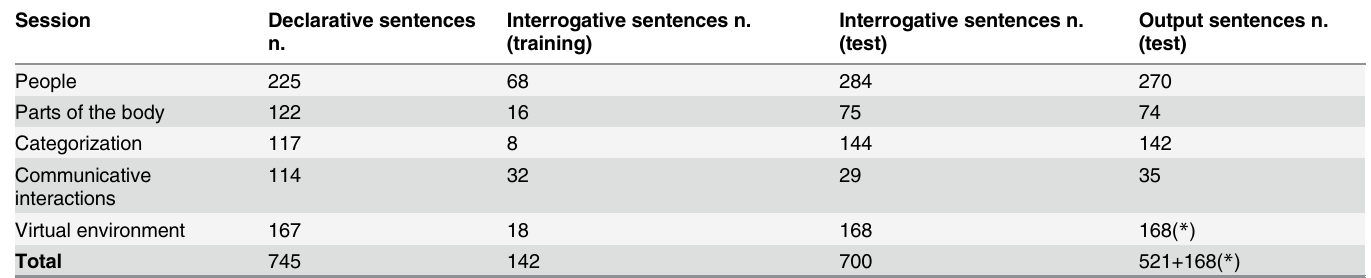
Table 3. Number of declarative sentences, number of interrogative sentences used for training, number of interrogative sentences used for the test and number of output sentences in the five learning sessions. The conversational sentences that do not expect a turn taking from the system are treated as declarative sentences, while the ones that expect a turn taking are treated as interrogative sentences. The output sentences in the virtual environ- ment ( * ) are actually commands issued by the system to perform actions in the environment itself. Session Declarative sentences